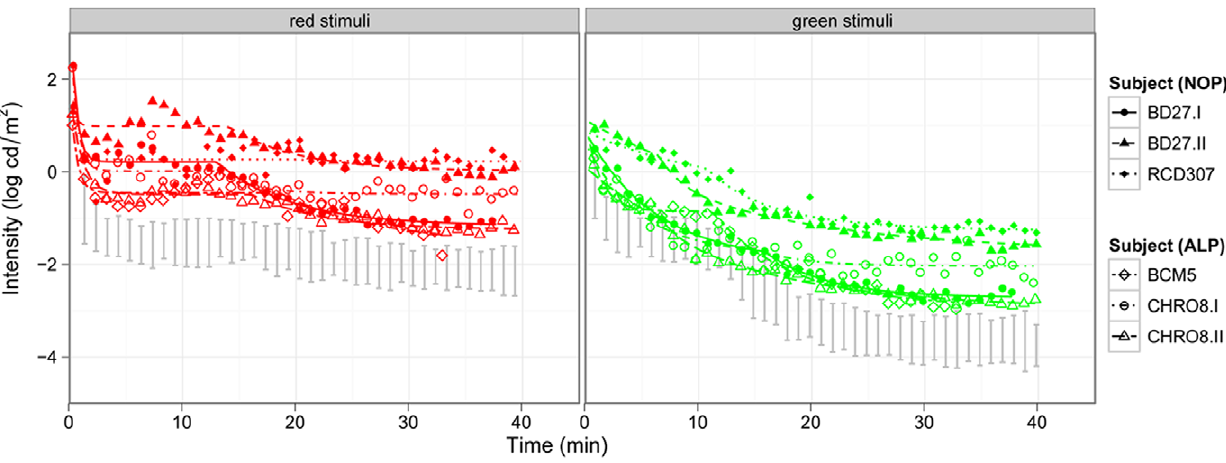
Figure 2. Dark adaptation curves of the patients of both groups compared to normal subjects. The left panel shows the cone (red stimuli), the right panel the rod function (green stimuli) of the NOP and ALP groups (the 95% confidence band of normal subjects is marked with grey). The threshold elevation for both target colors is biggest for two patients of the NOP group.